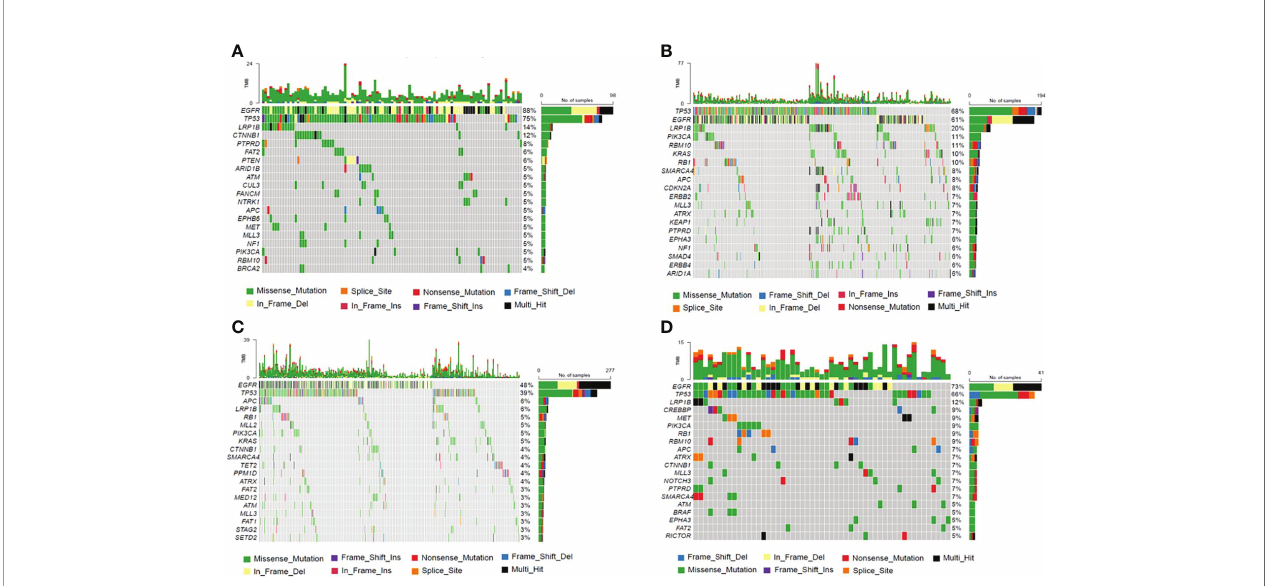
FIGURE 4 | The Frequency Spectrum for treated patients with detectable SNV or Indel mutations. (A) Mutation frequency spectrum in treated-CSF samples (six samples were not detected; they only showed the twenty most frequently mutated genes). (B) Mutation frequency spectrum in treated-tumor tissue samples (three samples were not detected; they only showed the twenty most frequently mutated genes). (C) Mutation frequency spectrum in treated-plasma (117 samples were not detected; they only showed the twenty most frequently mutated genes). (D) Mutation frequency spectrum in treated-other samples (two samples were not detected; they only showed the twenty most frequently mutated